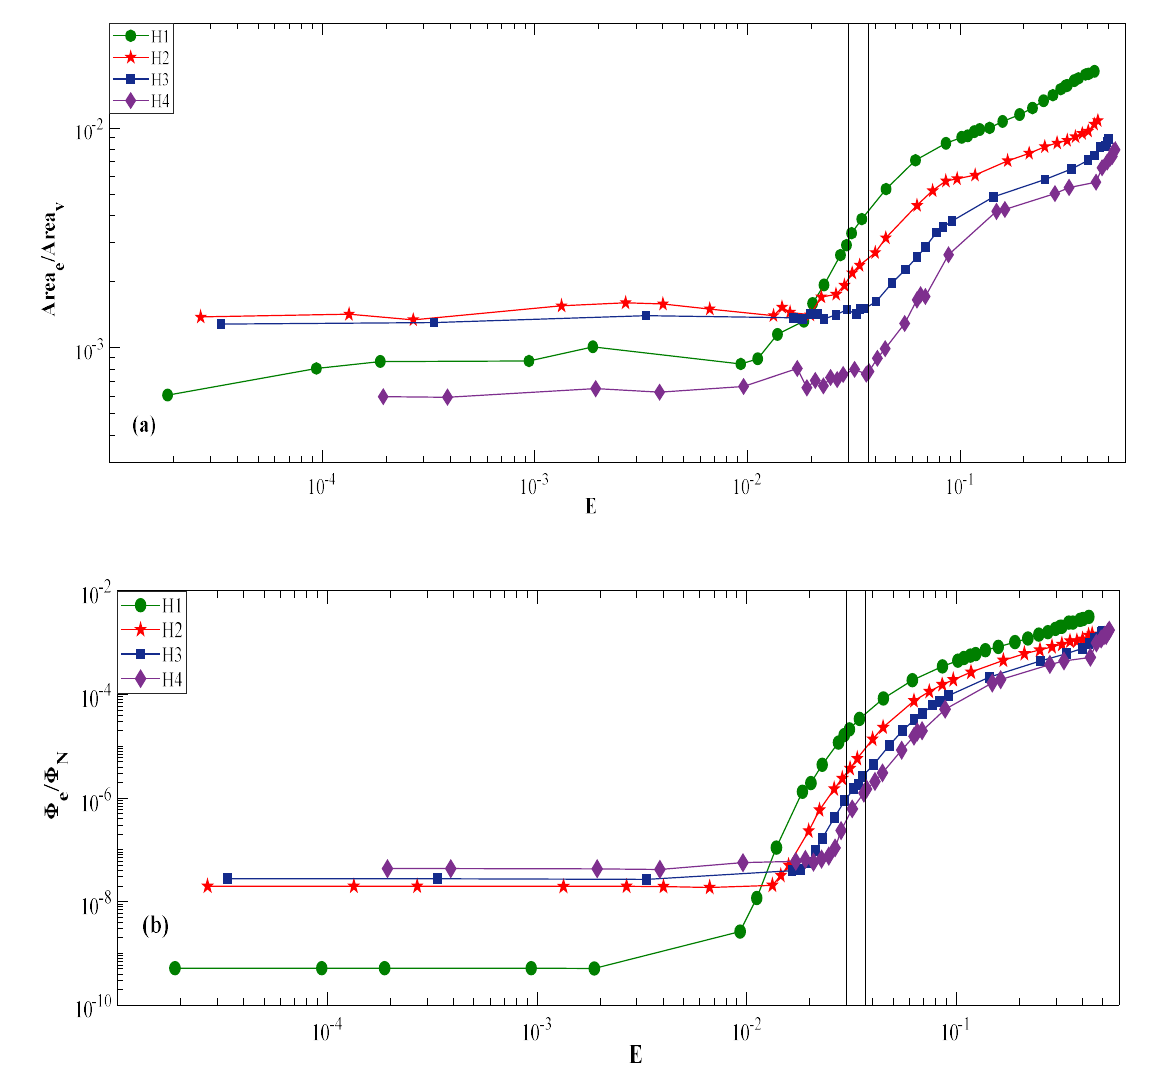
Figure 5. Effects of flow regime on the ( a ) area fraction of eddies; ( b ) eddy to total dissipation ratio.